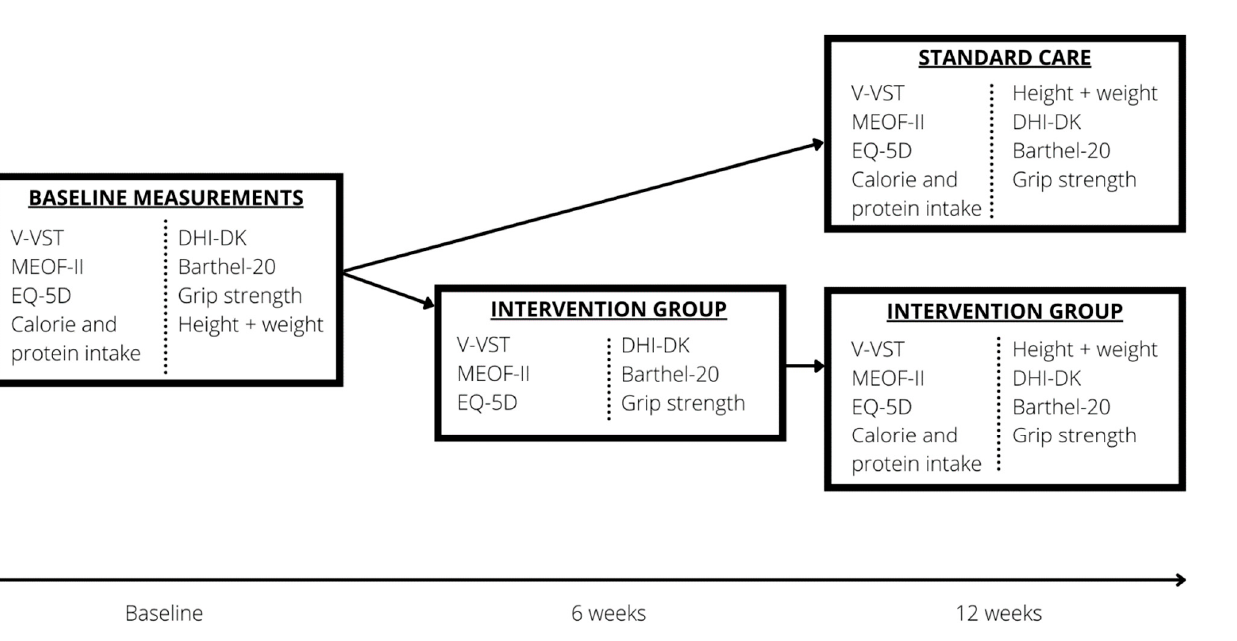
Figure 1. The study protocol. VVST: Volume Viscosity Swallow Test, MEOF-II: Minimal Eating Observation Form-Version II, EQ-5D: EuroQol-5 Domain, DHI-DK: Dysphagia Handicap